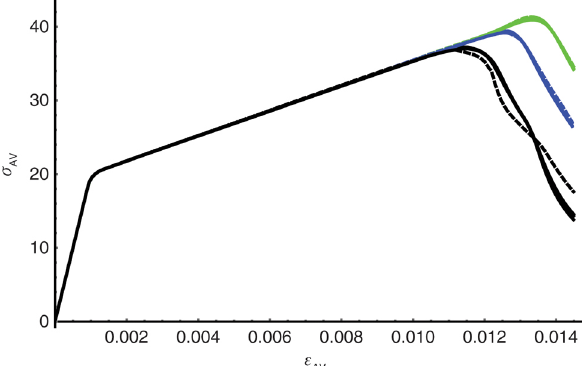
Figure 12: Shear: global stress response for a fast, medium and slow strain rate (green, blue and black), applied to 1024 (dashed), 3136, 6400 and 10,816